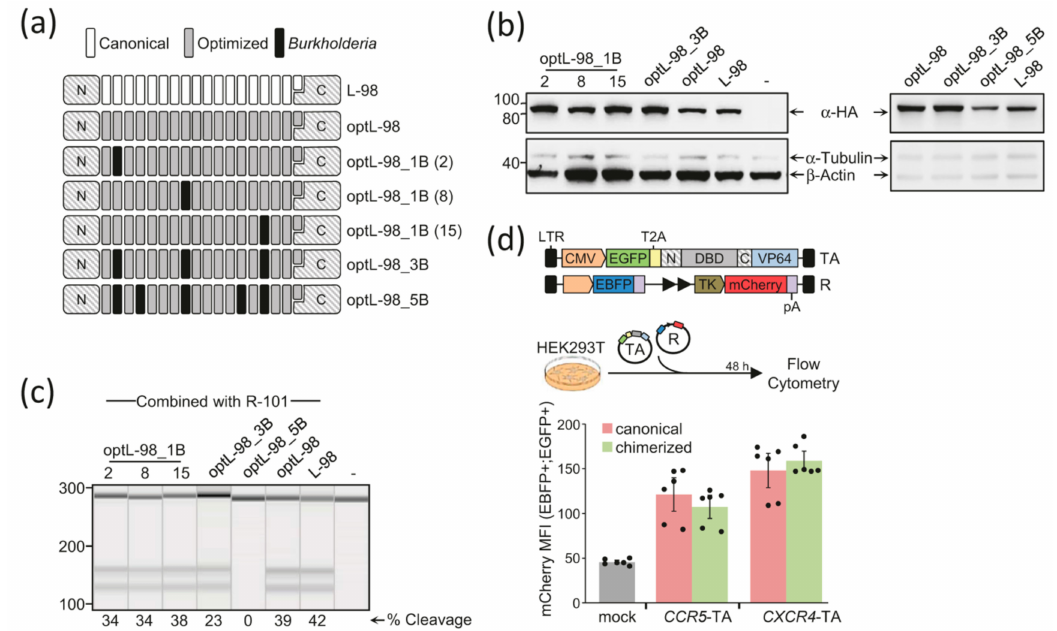
Figure 1. Chimerization results in functional TALE-based nucleases and transcriptional activators. ( a ) Schematics of chimerized TALE DNA binding domains (DBDs). The DNA sequence coding for canonical TALE-DBD (white) is extensively modified to minimize intra- and inter-module repetitiveness (grey). Inaddition, chimerizedTALE-DBDincludeTALErepeatsderivedfromthebacterium Burkholderia rhizoxinica (black). ( b ) Expression levels of chimerized TALE nucleases. Expression levels were determined by immunoblotting using antibodies against HA-tag (top panel). A combination of antibodies recognizing α -Tubulin and β -Actin (lower panel) are used to normalize the total protein content. The positions of the relevant proteins are indicated in the middle and the protein marker (in kDa) on the left. ( c ) Activity of optimized and chimerized TALE nucleases. Capillary electrophoresis gel image (QIAxcel System, Qiagen) showing the target locus disruption assayed by T7 Endonuclease 1 (T7E1) assay. The extent of cleavage (as percentage of modified alleles) is indicated below each lane. ( d ) Activity of chimerized transcriptional activators (TA). To monitor the activity of the TAs, we generated a reporter construct (R) that included the corresponding binding sites of the TAs in tandem (black triangles), followed by a minimal promoter fragment from the HSV thymidine kinase (TK) gene adjacent to a mCherry expression cassette (upper panel). The expression cassette for an enhanced blue fluorescent protein (EBFP) driven by the CMV is included to track the reporter construct. The activity of TAs was measured by co-transfecting the corresponding TALE-TA expression plasmid and the reporter in HEK293T cells (upper panel). The TAs are driven by a cytomegalovirus (CMV) promoter and, to track their expression, are fused to the C-terminus of an enhanced green fluorescent protein (EGFP) via a T2A peptide. TAs containing either the canonical (light red) or the best-performing chimerized TALE-DBD (light green) were compared side-by-side for their ability to bind to their intended target sites and drive mCherry expression via flow cytometry, 48 h post transfection. The histogram shows the mCherry expression levels (mean ± SEM), measured as mean fluorescence intensity (MFI), in the fraction of cells that received both the e ff ector (EGFP + ) and the reporter plasmids (EBFP + ). Each dot represents a single data point. Basal mCherry expression levels are measured by transfecting an e ff ector plasmid lacking the DNA binding domain (mock, grey bar). pA, poly adenylation signal and LTR, long terminal